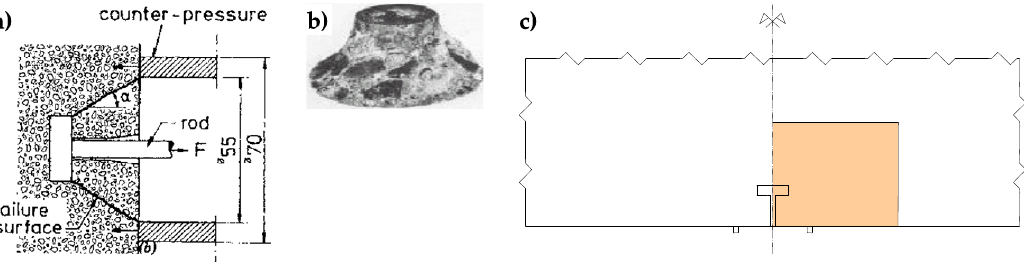
Figure 2. The Lok-test: ( a ) Geometric characteristics of the insert and counter-pressure ring for the pullout test. ( b ) Shape of the extracted portion in concrete solids. ( c ) Shape of the modeled domain.